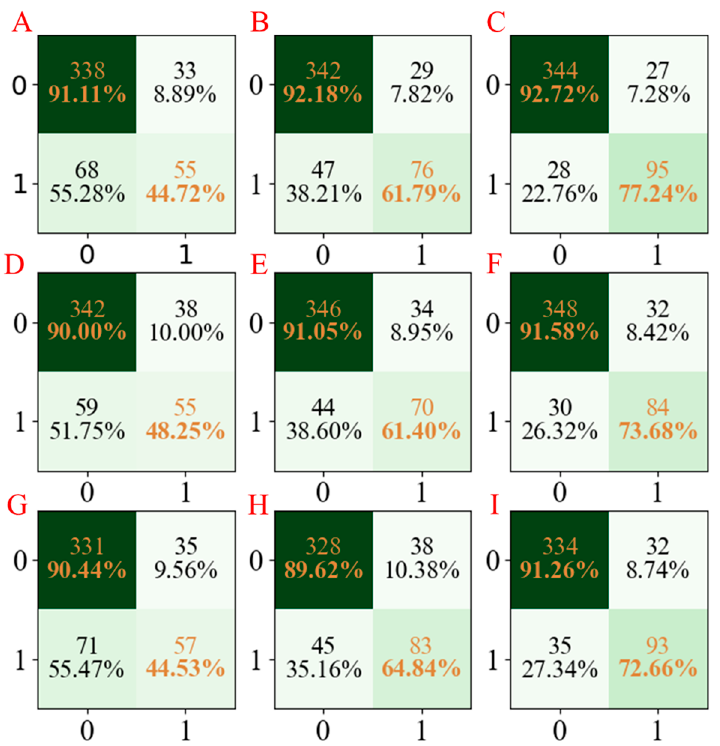
Figure 6. The confusion matrix of three models established for HOB characteristics. The confusion matrix of the PLS-DA model using seed numbers 1234 ( A ), 5678 ( D ), and 1278 ( G ); the confusion matrix of the AdaBoost model using seed numbers 1234 ( B ), 5678 ( E ) and 1278 ( H ); the confusion matrix of the LGBM model using seed number of 1234 ( C ), 5678 ( F ), and 1278 ( I ). Table 4. The precision, recall, and F1-score values of the established models forHOB properties. Methods